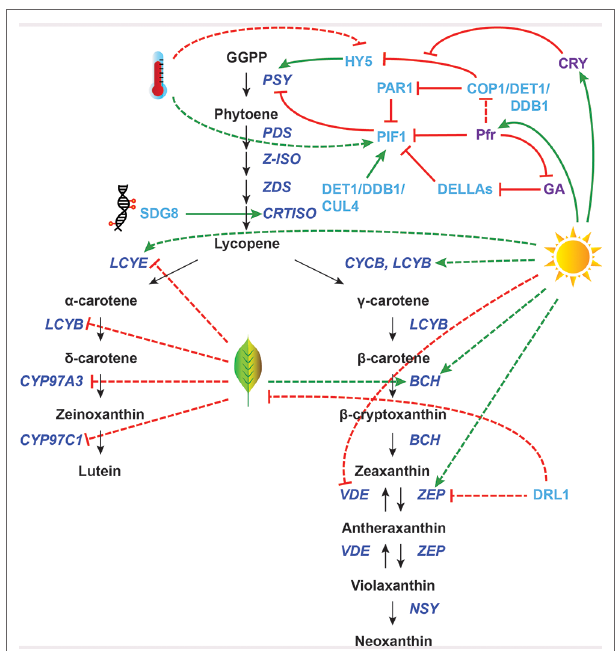
FIGURE 1 | Transcriptional regulation of carotenoid biosynthesis pathway (CBP) genes in photosynthetic tissues. The regulation of CBP genes in response to light (sun), senescence (leaf), and high temperature (thermometer) and by epigenetic controls (DNA) is shown. The carotenoid biosynthesis pathway is in black, with carotenoid biosynthesis genes indicated in dark blue. Carotenoid regulators discussed in the paper are shown in light blue, with other regulators in purple. Green arrows indicate positive regulation, while blunt red arrows indicate negative regulation. Solid lines show direct interactions, while dotted lines show indirect/unknown interactions. GGPP, geranylgeranyl pyrophosphate; PSY, phytoene synthase; PDS , phytoene desaturase; Z-ISO , 15-cis-zeta-carotene isomerase; ZDS, zeta-carotene desaturase; CRTISO, carotene isomerase; LCYB, lycopene beta-cyclase; CYCB , chromoplast-specific lycopene beta-cyclase; BCH, beta-carotene hydroxylase; ZEP, zeaxanthin epoxidase; VDE, violaxanthin deepoxidase; NSY , neoxanthin synthase; LCYE , lycopene epsilon-cyclase; CYP97A3, cytochrome P450–type beta-hydroxylase; CYP97C1, cytochrome P450–type